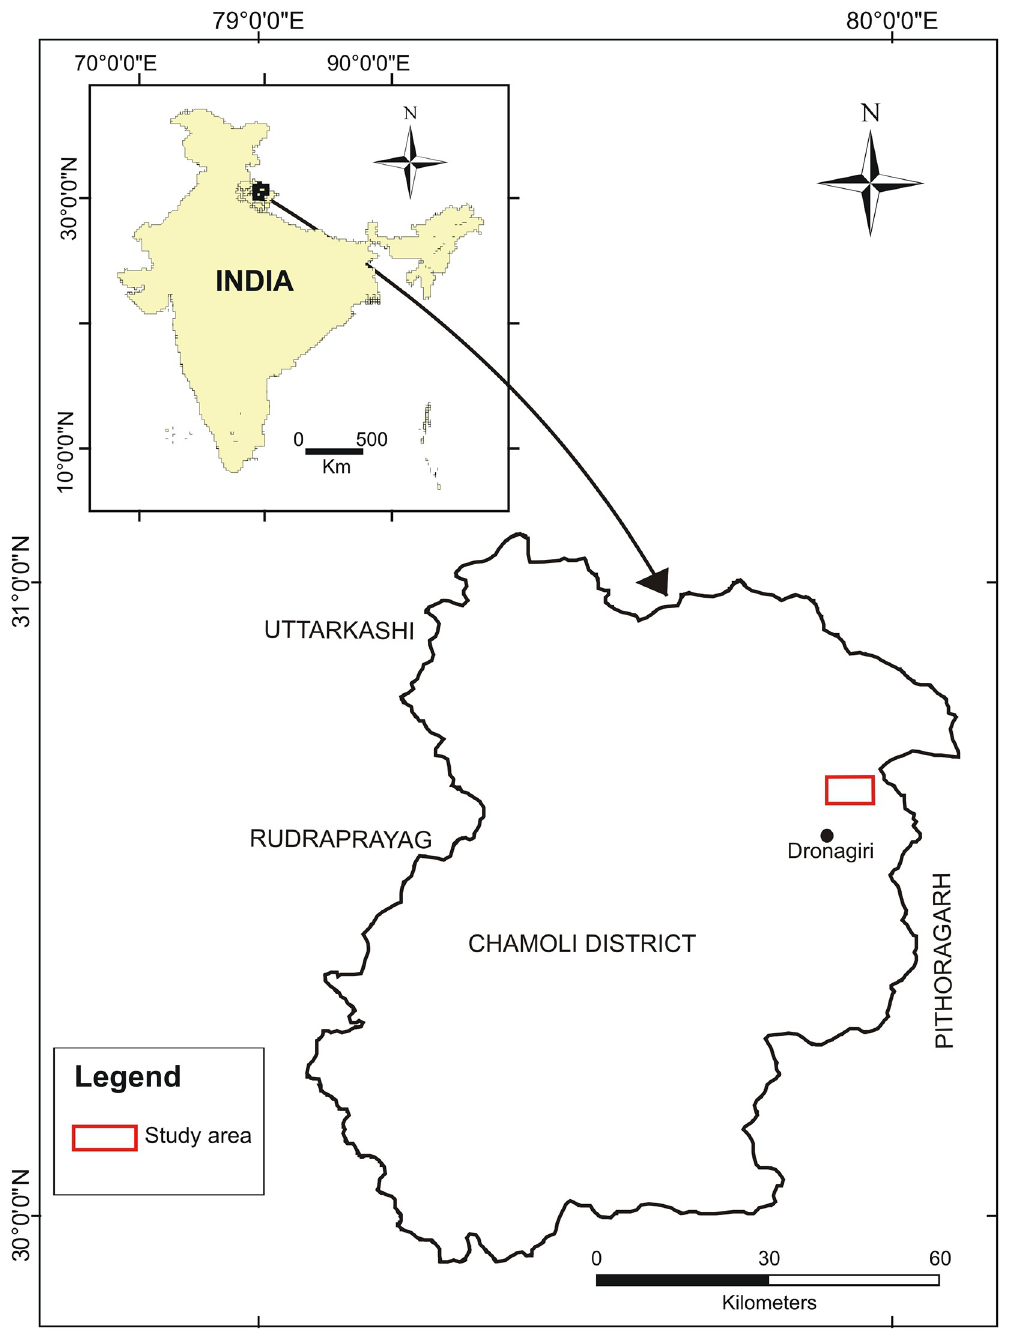
Fig 2. Map showing the location of the studied area. will tolerate temperatures as low as -40˚C [35]. The climate of the region is mild during sum- mer and very cold during winter. The maximum temperature ranges up to 12˚C in summer and down to -20˚C during winter. Other associated herbivorous mammals in the region include Hemitragus jemlahicus (Himalayan tahr) and Moschus leucogaster (White-bellied musk deer).